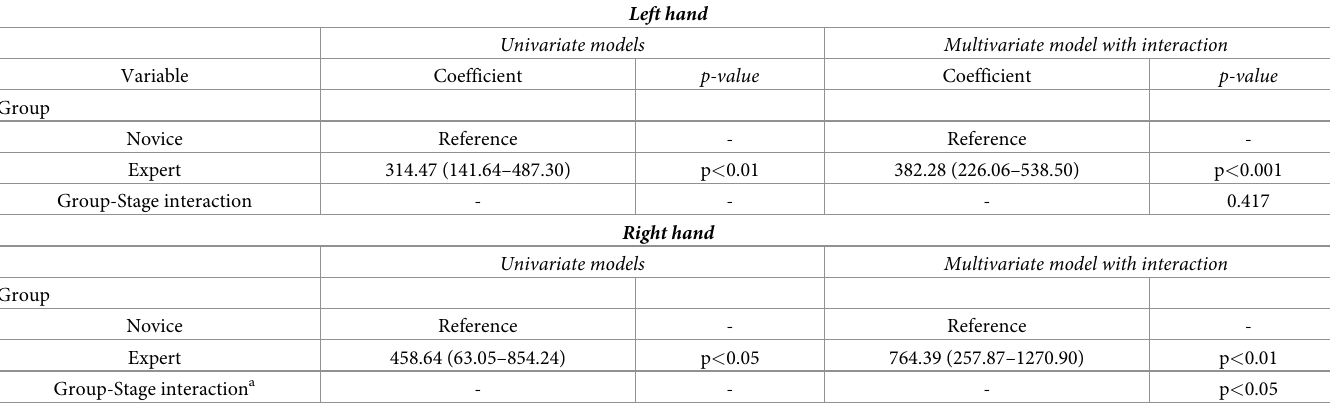
Table 3. Univariate and multivariate linear models to determine differences in acceleration by group, session, and their interaction, for both hands.